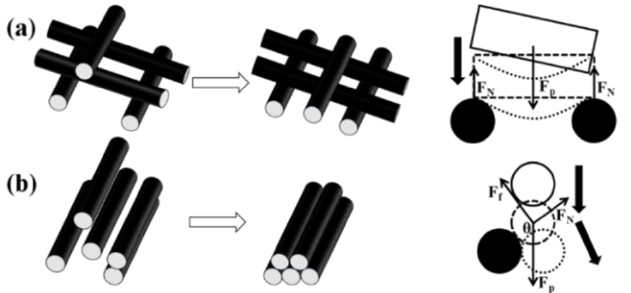
Figure 6. Schematic diagrams of formations of the maximum packing state and force analyses of cylindrical fibers with a criss-cross structure ( a ) and a parallel structure ( b ). The arrows represent the directions of the fiber slippage.